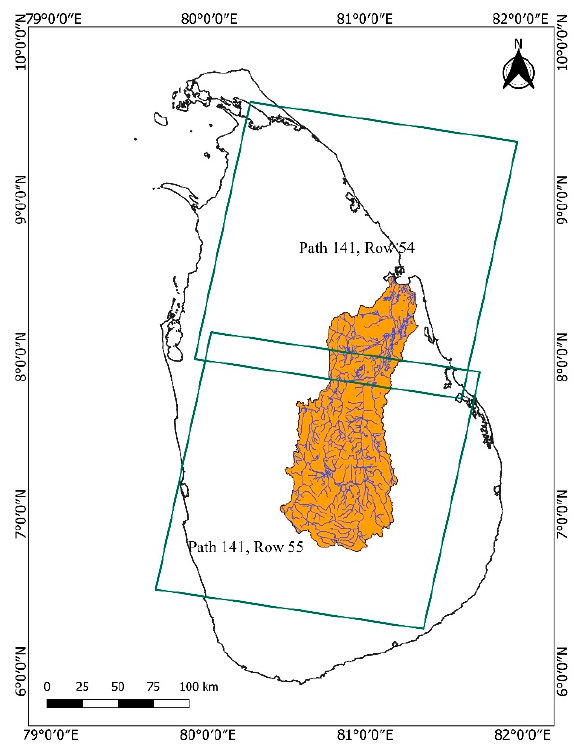
Figure 3. Arrangement of Landsat scenes covering the study area .